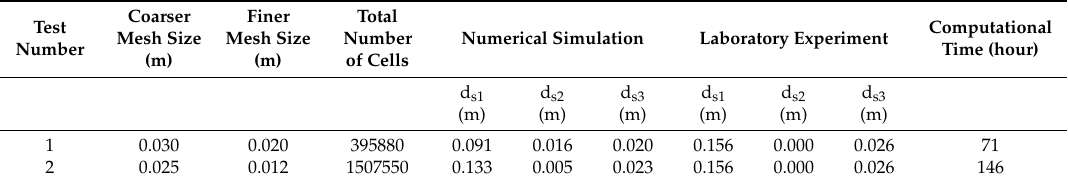
Table 2. Mesh size sensitivity